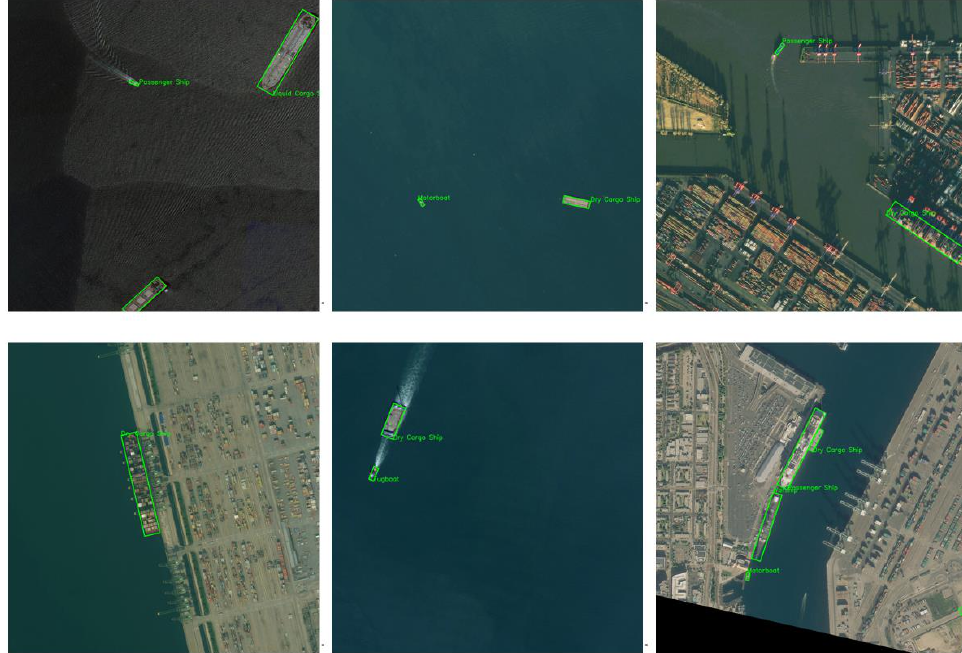
Figure 8. Some of the detection results obtained from part of FAIR1M dataset with our backbone in different state-of-the-art methods.